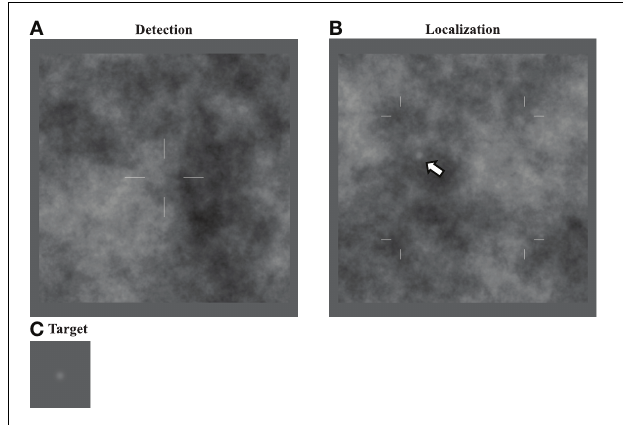
FIGURE 1 | Detection and localization stimuli. Image displays for the detection (A) and localization (B) tasks. The target to be detected is a Gaussian (“bump”) profile (C) embedded in power-law noise with an exponent of 2 here. For the detection task, the target is located at the center of the cross when it is present. In the localization task, the target can be located anywhere within the search area indicated by the marks